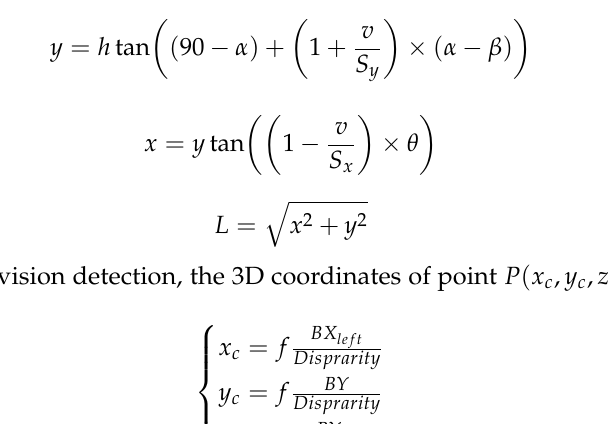
In the above equations, the distance from the camera to the ground is d , the shortest y , and the longest distance is distance mapped to the ground from the vertical angle is Through monocular and binocular parallax analysis, it is revealed that the obtained b images and seedling information have difficulty meeting the requirements of high real-time yy + . Values of d yyx + are collected by measuring tools. and refer to ,, 1 b 11 b seedling growth. Therefore, for the acquisition of seedling phenotype images, an integral the number of rows and columns of the images taken, respectively. The images taken are projection and region growing algorithm [24] fit for image position detection is adopted to grayscale images of seedlings at different stages with a resolution of 1280 × 900 pixels. detect the position of seedling in the first frame image. Machine learning algorithm is used Where taking xoy as the coordinate system, y is the vertical distance between the seedling for detection and analysis in real time to obtain accurate seedling phenotype information and the camera, x is the horizontal distance between the seedling and the camera, and L more represents the actual distance between the seedling and the camera.